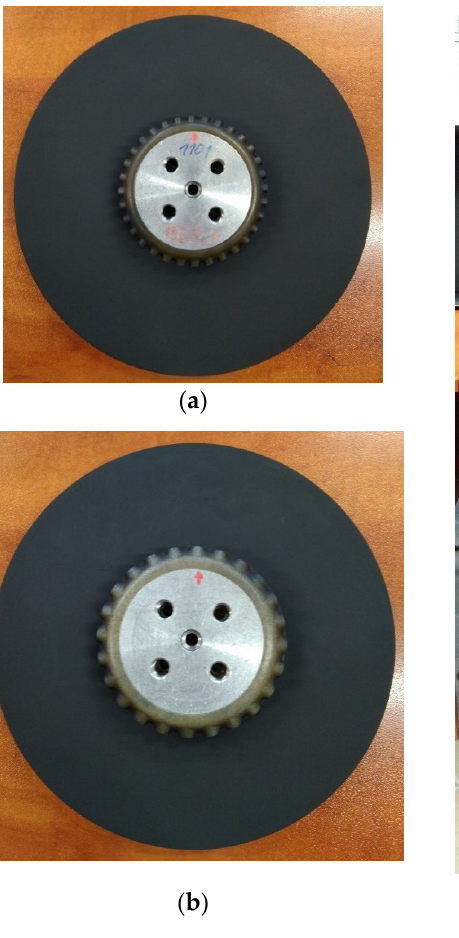
Figure 5. The experimental setup for IRT testing of PMC disks: ( a , b ) Larger and smaller disks covered with black enamel; ( c ) The general view of the experimental setup.